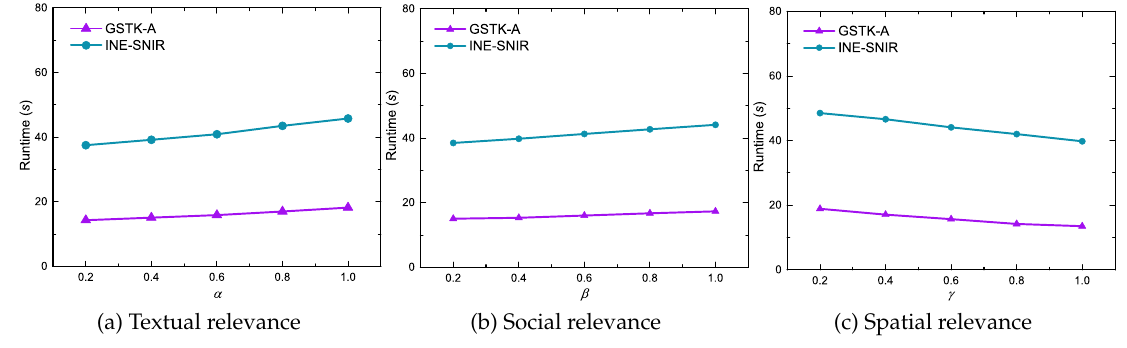
Figure 10. Effect of query parameters on